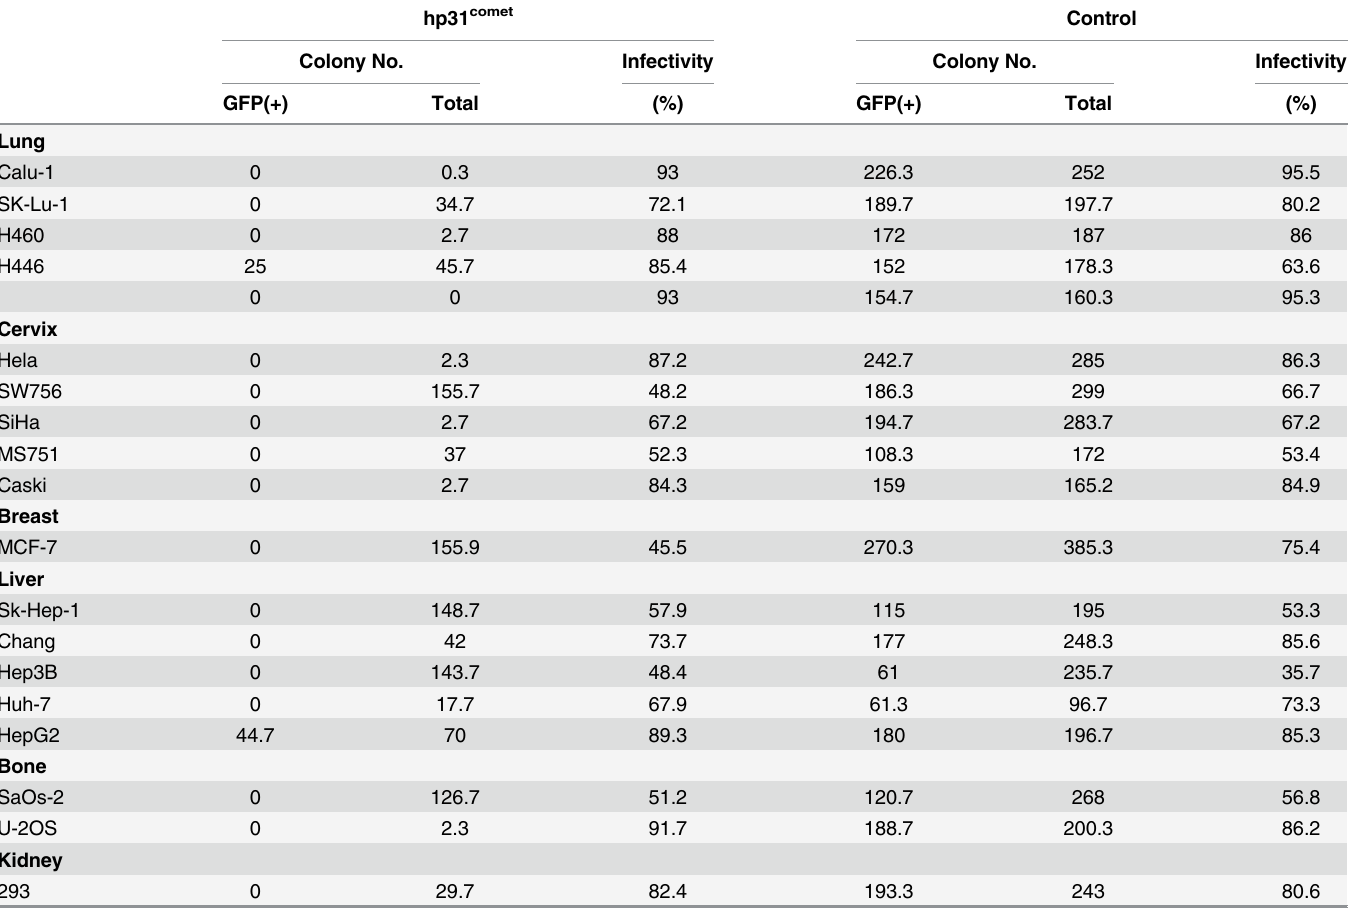
Nineteen human cancer cell lines were infected with retroviruses containing hp31comet-IRES-EGFP or empty control IRES-EGFP plasmids. The numbers of resulting GFP-positive and -negative colonies were counted. The totals re fl ect the sums of such colonies. Each infectivity value is a percentage of the number of GFP-positive cells that underwent retroviral